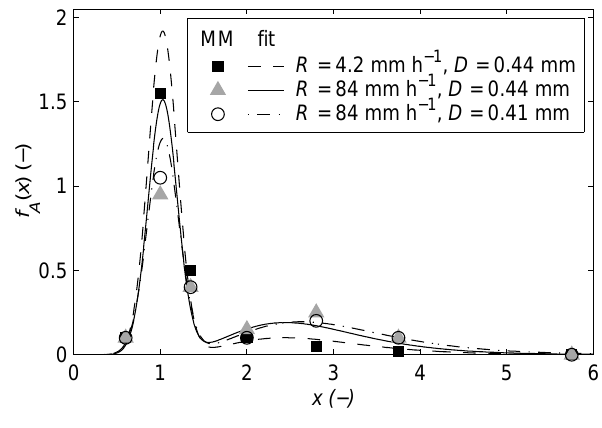
Fig. 1. Probability density functions (pdfs) of the ratio of fall ve- locities f A (x) compared to the pdfs shown in Fig. 2b of Montero- Mart ´ ınez et al. (2009) (MM in legend), for different drop sizes and rainfall intensities. Note that Fig. 2b of Montero-Mart´ınez et al. (2009) (and hence the symbols in this graph that are derived from this) do not represent true pdfs, as the area below these graphs is not